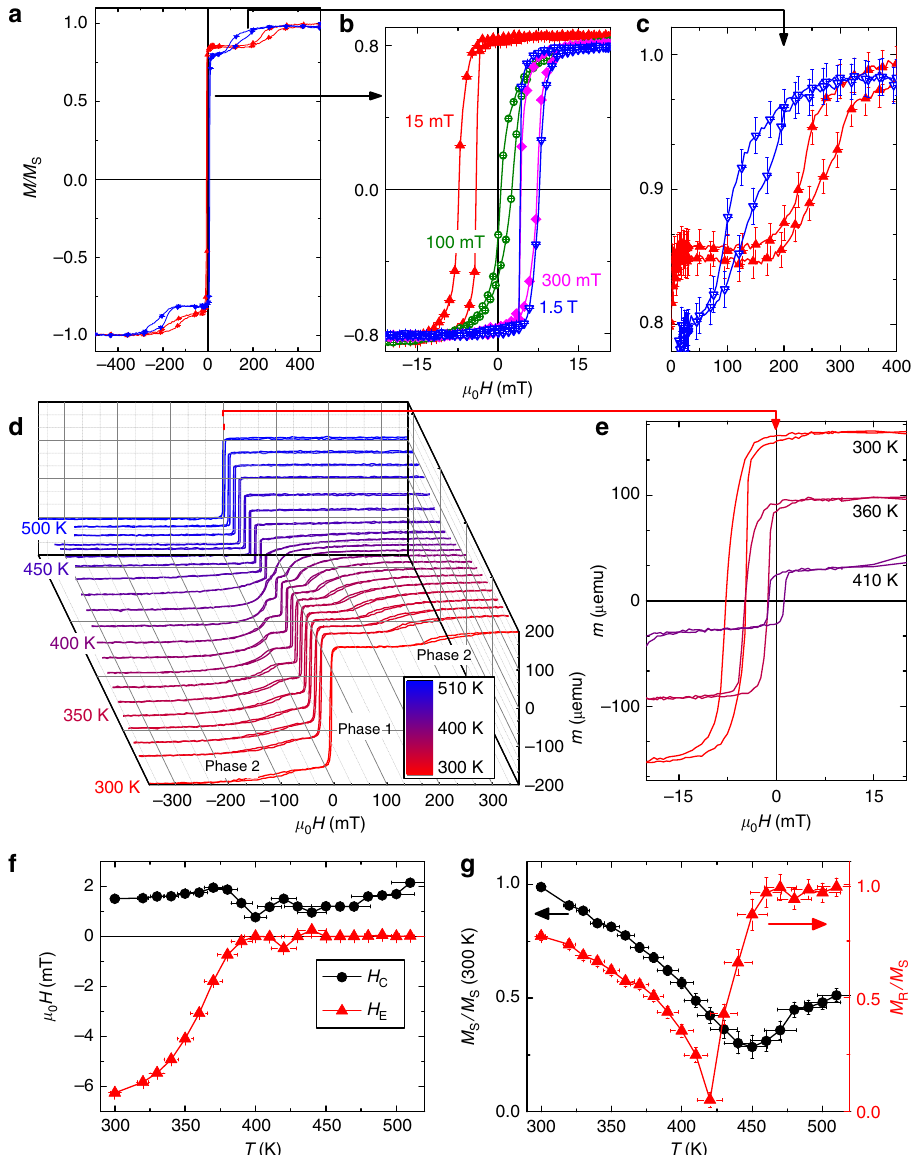
Figure 1 | Magnetometry results for sample A (Gd 0.42 Fe 0.58 /NiCoO). ( a ) Room-temperature hysteresis loops under different cooling fields. ( b , c ) Zoomed-in views of phase 1 and phase 2, respectively, as indicated by arrows. The colored loops in a – c correspond to cooling fields of 15mT (red), 100mT (green), 300mT (pink), and 1.5T (blue). Temperature-dependent ( d ) hysteresis loop (300–510K, marked by the scale bar, with a zoomed-in view of the phase 1 loops shown in e ), ( f ) coercivity and bias, and ( g ) saturation magnetization and squareness are shown after field cooling in 15mT. Error bars are determined by the machine sensitivity limits. For clarity, not all data points are